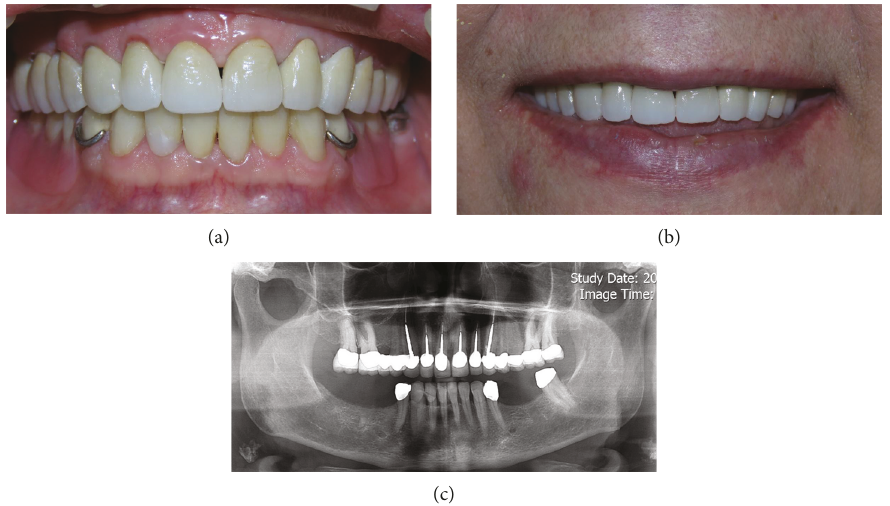
Figure 8: Postoperative images: (a) intraoral view, (b) smile view, and (c) postoperative panoramic